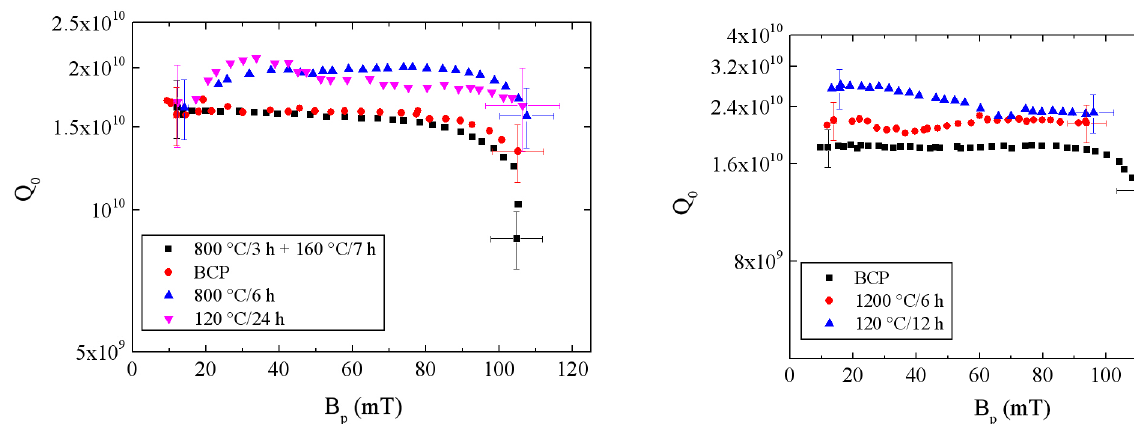
ð 2 : 0 K Þ vs B FIG. 4. Q p measured after the first HT at 800 0 followed by BCP, by the second HT at 800 (cid:1) C and by LTB.